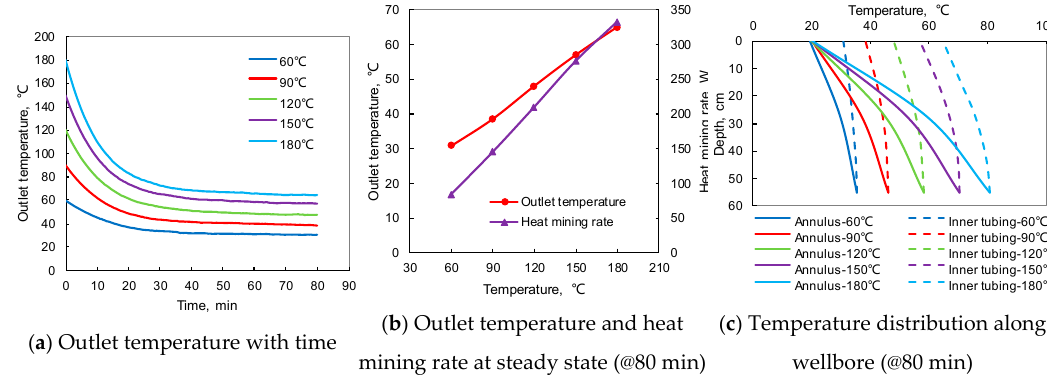
Figure 11. Temperatures at the outlet and along the wellbore under different reservoir temperatures.